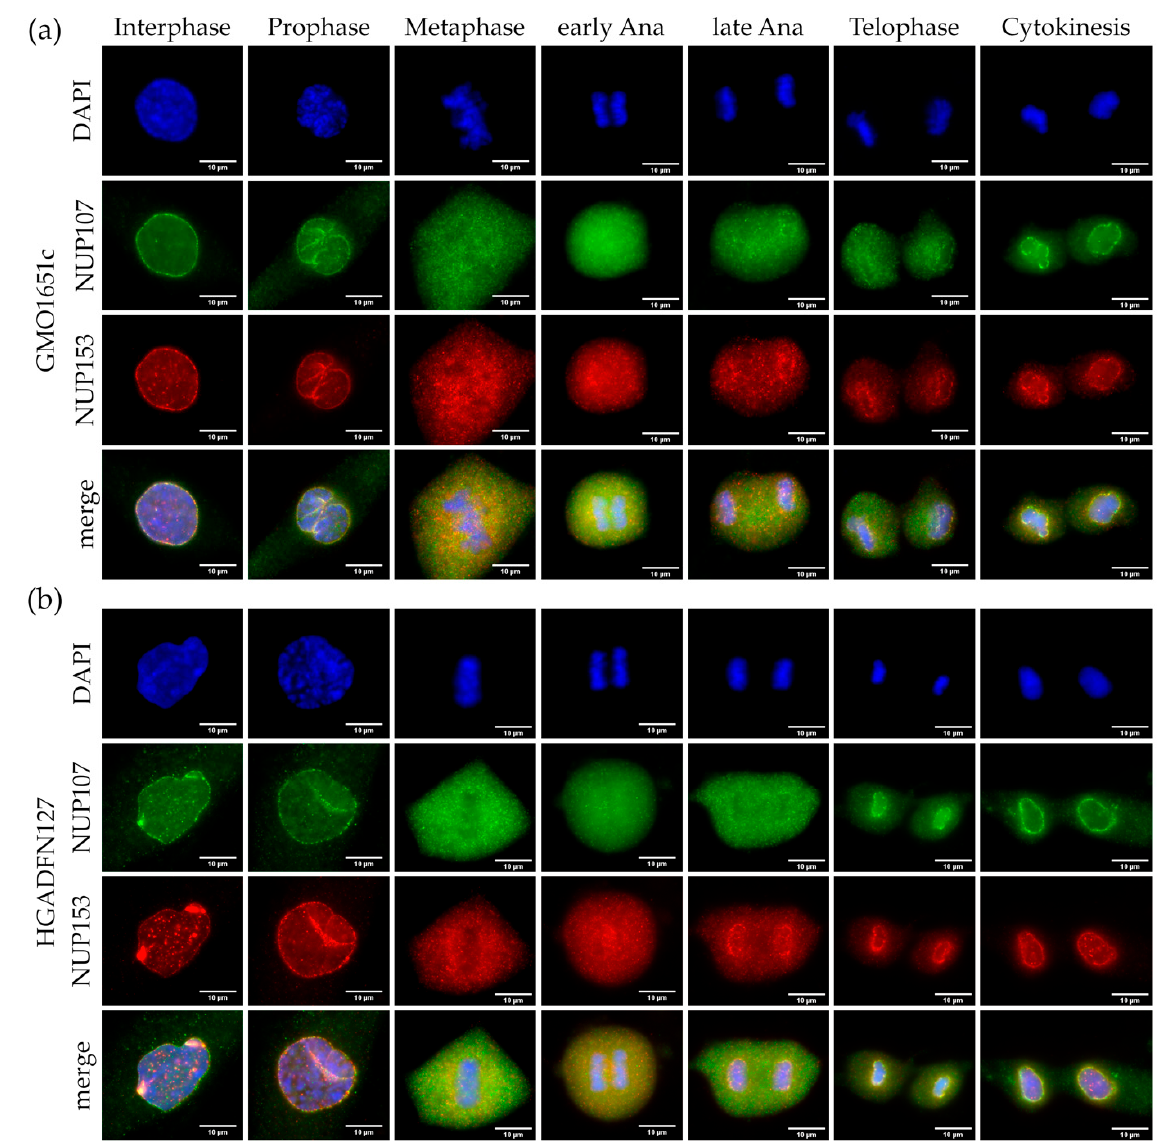
Figure 4. Recruitment of basket nucleoporin NUP153 and scaffold nucleoporin NUP107 was not affected in HGPS. Immunocytochemistry of ( a ) control (GMO1651c) and ( b ) HGPS (HGADFN127) fibroblasts using α -NUP107 and α -NUP153 antibodies, counterstained with DAPI. NPCs cluster in interphase HGPS cells ( b ), unlike the evenly distributed punctate pattern in control interphase ( a ). Recruitment of NUP153 to anaphase chromosomes is not affected in HGPS cells when compared to control. No defect in NUP153 or NUP107 localization can be observed in HGPS from prophase to cytokinesis. n ≥ 3.